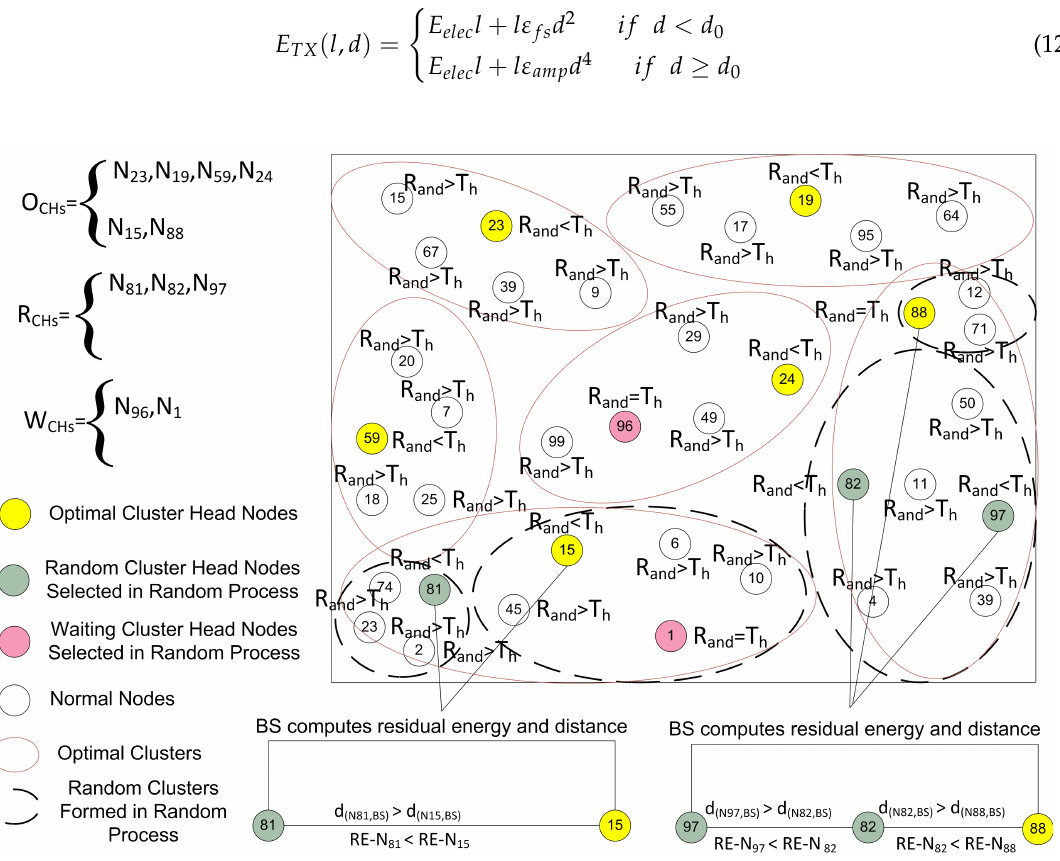
Figure 6. The optimal number of CH selection, and optimal number of cluster formation in the